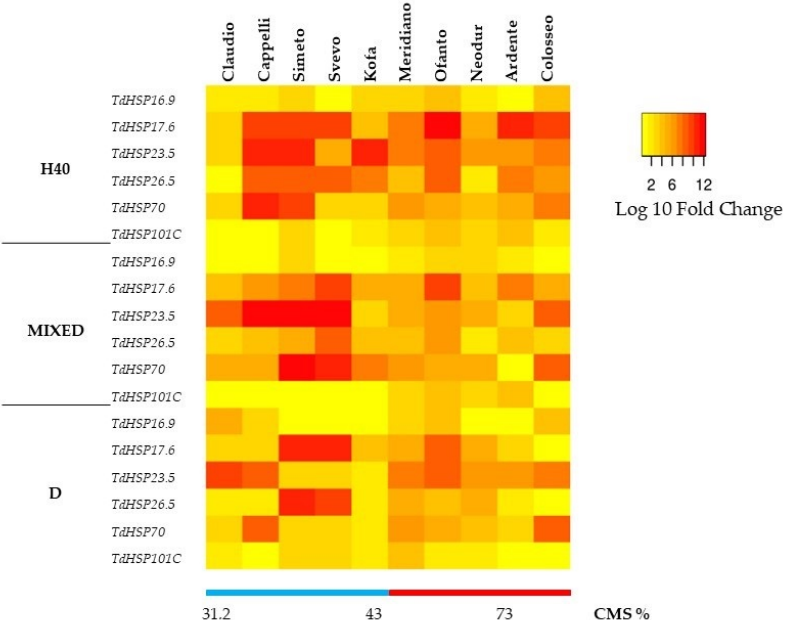
Figure 5. Heat-map showing the relative expression of TdHSP16.9, TdHSP17.6, TdHSP23.5, TdHSP26.5, TdHSP70 and TdHSP101C measured in wheat seedlings of ten different cvs in response to heat stress (2 h at 40 ◦ C = H40), MIXED stress (drought stress 2 h followed by heat stress 2 h at 40 ◦ C), and to drought stress (2 h = D). Data are expressed as log10 Fold-change (FC). The order of cvs is related to their acquired thermotolerance (ThA_34) evaluated by CMS